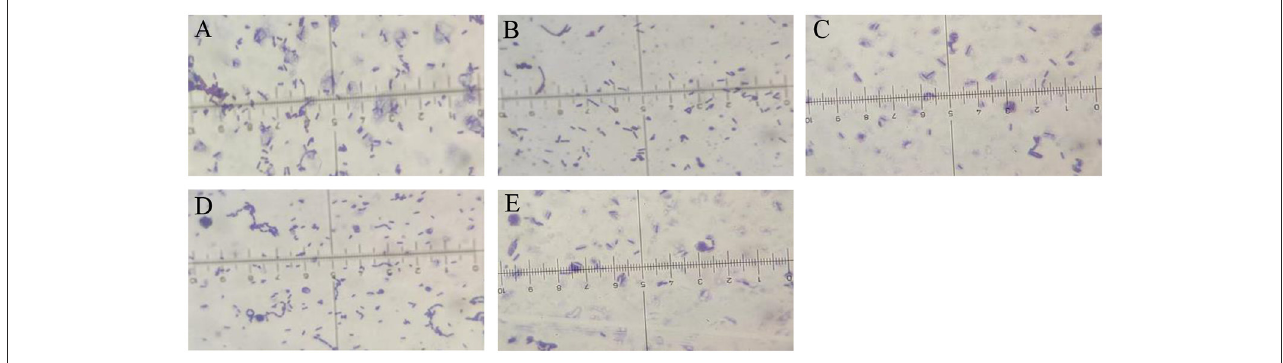
FIGURE2 Microscopic images of the selected bacterial strains. Gram stain was used to enhance the visibility of the bacteria. (A) Z-14, (B) JY122, (C) ZY133, (D) JY214, and (E) NW03.